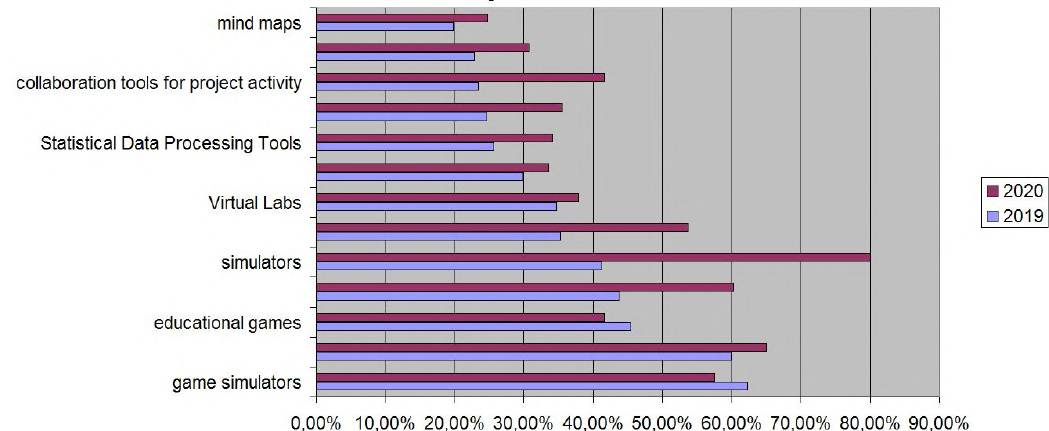
Figure 36: Presentation of paper